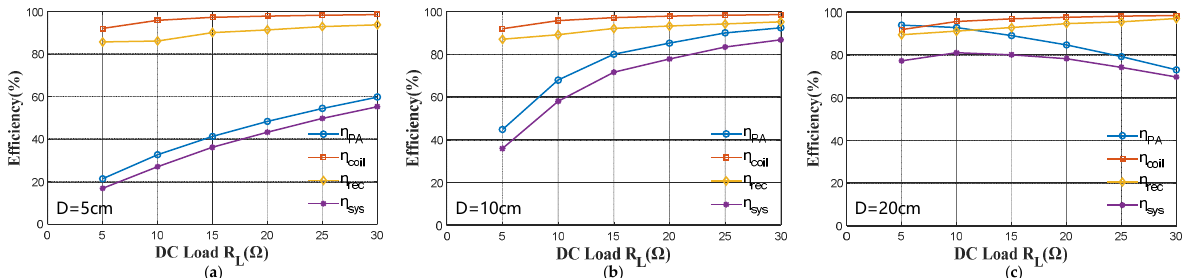
Figure 3. Efficiencies of Class-E PA, coupling coil link, Class-E Rectifier, and overall system with different coil distance D and DC load R L : ( a ) D = 5 cm, ( b ) D = 10 cm, ( c ) D = 20 cm.